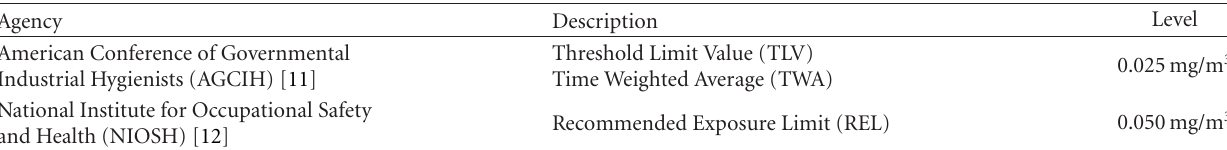
Table 1: Recommended exposure limits for respirable crystalline silica in occupational